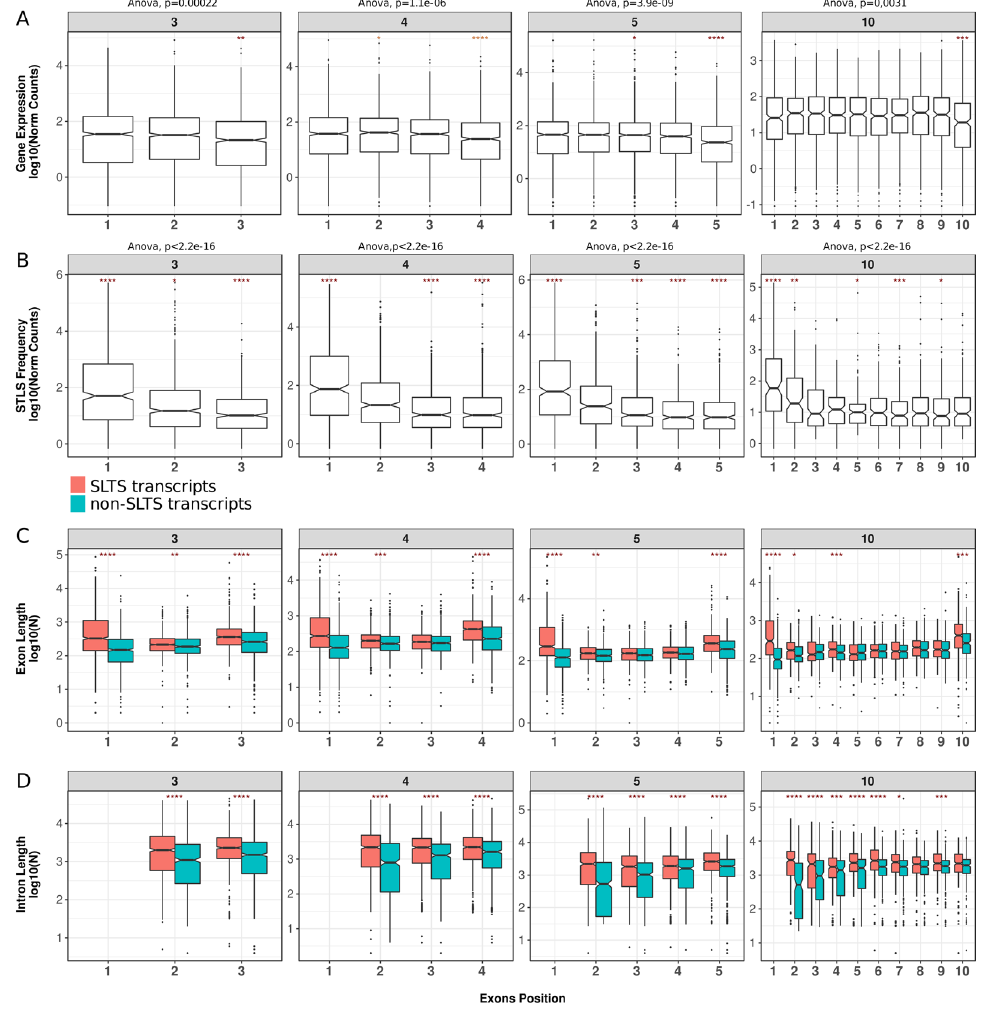
Figure 6. Trans-splicing occurrence by exons position in gene bodies and exon and intron lengths. ( A ) Expression levels of exons according to their position in transcripts (estimated from the RNA-Seq public dataset). ( B ) Frequency of trans-splicing according to exon position (estimated from SL Trapping). For A and B groups of genes were divided according to their number of annotated exons. Only genes with three, four, five and ten exons are shown. Analysis of variance (ANOVA) were performed followed by pairwise t-test ( * p < = 0.05, ** p < = 0.01, *** p < = 0.001, **** p < = 0.0001). For a better visualization, pairwise differences were also tested by Tukey’s Honest significant difference test and the results are plotted on Figure S4. ( C ) Distribution of exon lengths in trans-spliced (pink boxes) and non-trans-spliced (blue boxes) genes that present three, four, five and ten exons. ( D ) Distribution of introns lengths immediately upstream of the splicing event in trans-spliced (pink boxes) and non-trans-spliced (blue boxes) genes presenting three, four, five and ten exons. For data in C and D, t-test were performed: * p < = 0.05, ** p < = 0.01, *** p < = 0.001, **** p < =